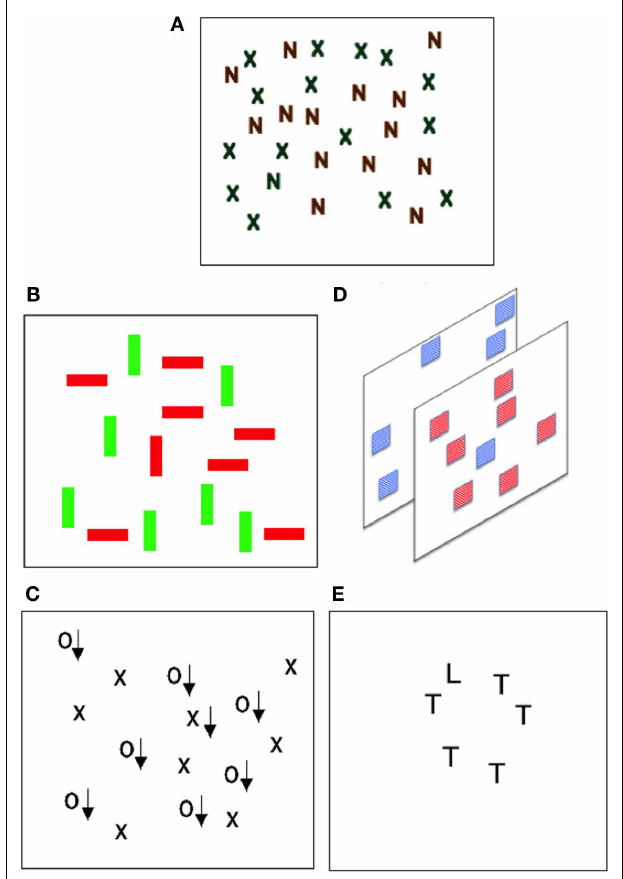
FIGURE 2 |Varieties of conjunction search. Much of the research on selection and binding has used visual search tasks. Participants response times to find a particular target amongst distractors is compared. (A) Shows the classic “conjunction search” display, shown byTreisman and Gelade to produce inefficient search performance. (B–E) Each illustrate cases of efficient conjunction search. (A) Treisman and Gelade (1980). Inefficient color – form conjunctions. Finding the green N is difficult. (B) Wolfe et al. (1989). Efficient color – orientation conjunctions. Finding the red vertical bar is easy. (C) McLeod et al. (1988). Efficient motion – form conjunctions. Finding the moving X (arrows indicate motion) is easy. (D) Nakayama and Silverman (1986). Efficient color – depth conjunctions. Finding the front blue square is easy. (E) Duncan and Humphreys (1989). Efficient orientation – orientation conjunctions. Finding the L is